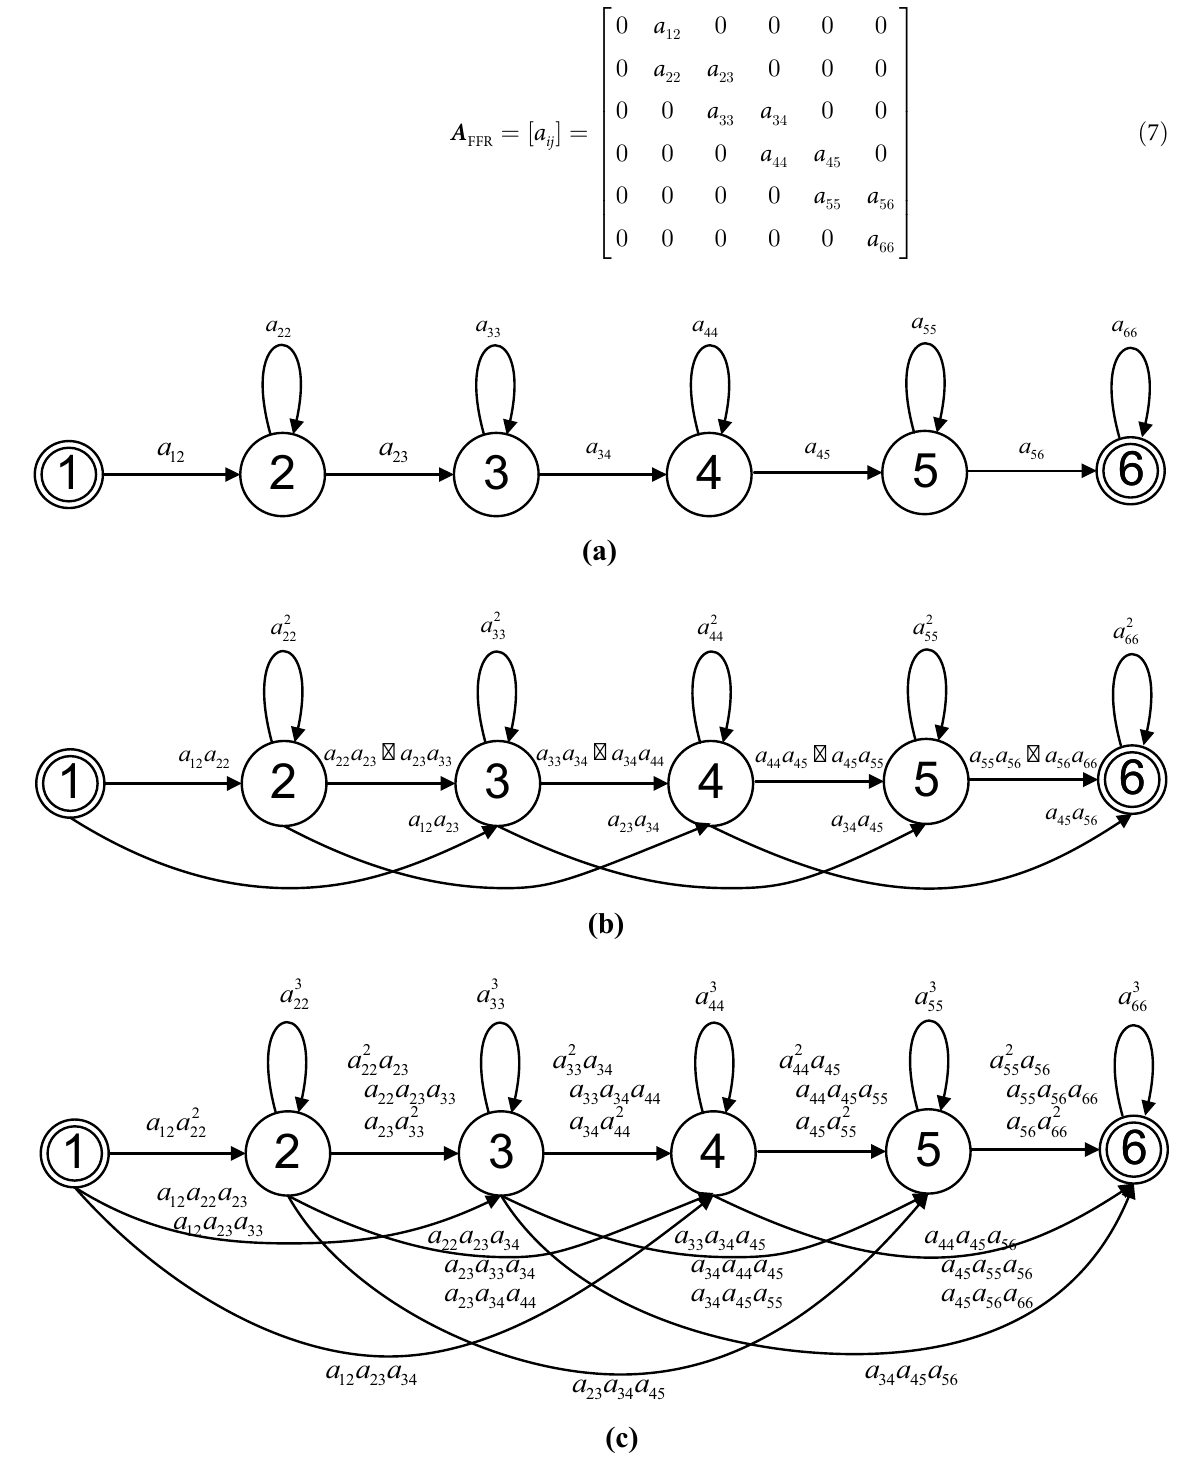
Fig 1. Topologies for original FFR HMM and corresponding adapted HMMs. (a) Original six-state HMM topology. (b) Adapted HMM topology for half frame rate ( D = 2). (c) Adapted HMM topology for one-third frame rate ( D = 3). https://doi.org/10.1371/journal.pone.0206916.g001 PLOS ONE | https://doi.org/10.1371/journal.pone.0206916 November7,